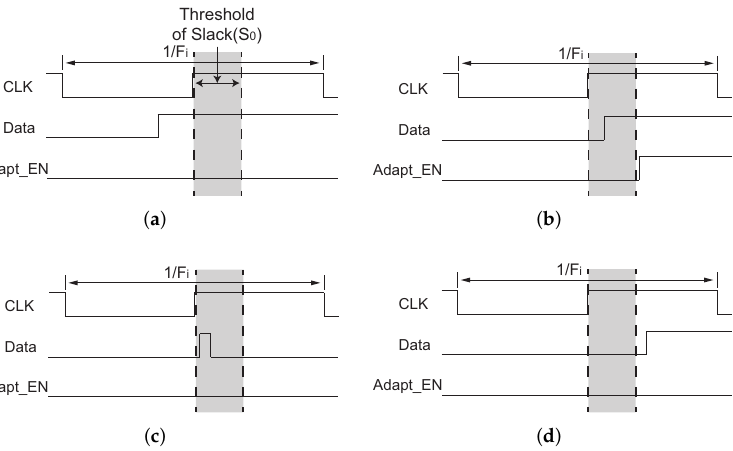
Figure 3. Four conditions of data/clock transition at FF 1 ( FF 2 ), and the adaptation decision made by the Binning Checker . ( a ) The monitored path does not cause binning failure, Adapt_EN stays at 0 ;